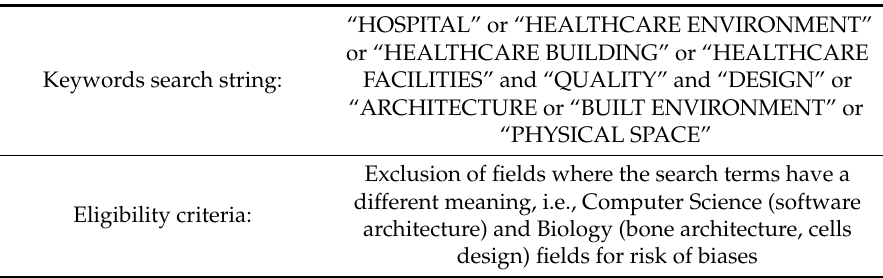
Table 1. Keyword identification and eligibility criteria used.